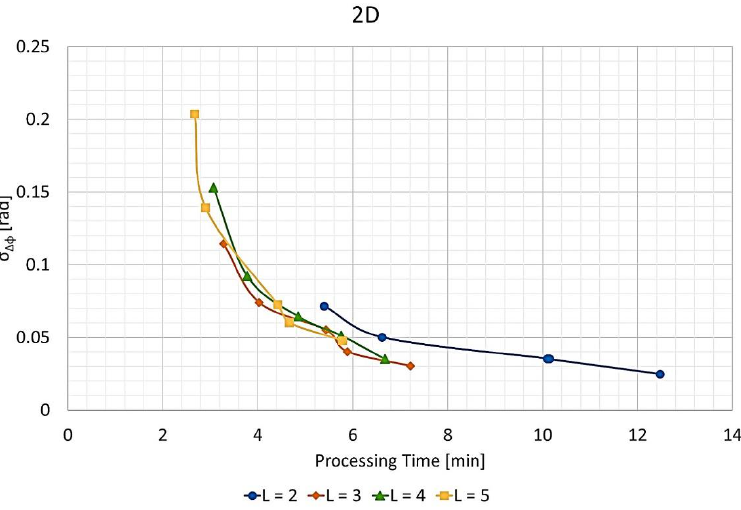
Figure 17. Phase error standard deviation σ ∆ φ vs. processing time for the 2D output images and different values of L .